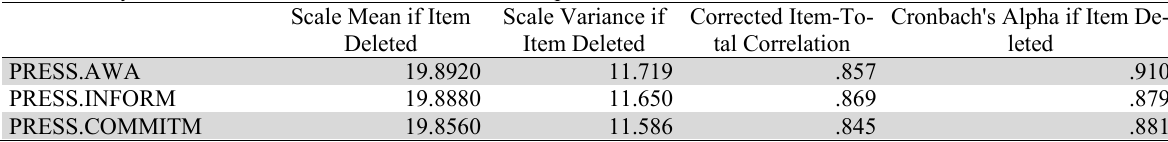
The summary of the final value measured for Cronbach Alpha Scale Mean if Item Scale Variance if Corrected Item-To- Cronbach's Alpha if Item De- Deleted Item Deleted tal Correlation leted PRESS.AWA 19.8920 11.719 .857 .910 PRESS.INFORM 19.8880 11.650 .869 .879 PRESS.COMMITM 19.8560 11.586 .845 .881